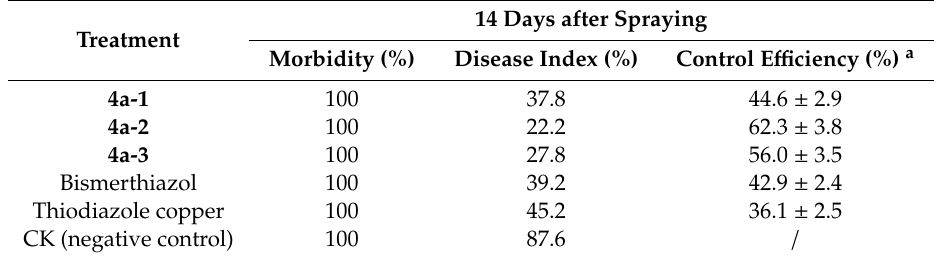
Figure 4. SEM images for Xoo after incubated using different concentrations of compound 4a-2 , ( A ) 0 µg/mL, ( B ) 25 µg/mL and ( C ) 50 µg/mL. Scale bar for ( A ), ( B ) and ( C ) are 5 µ m.